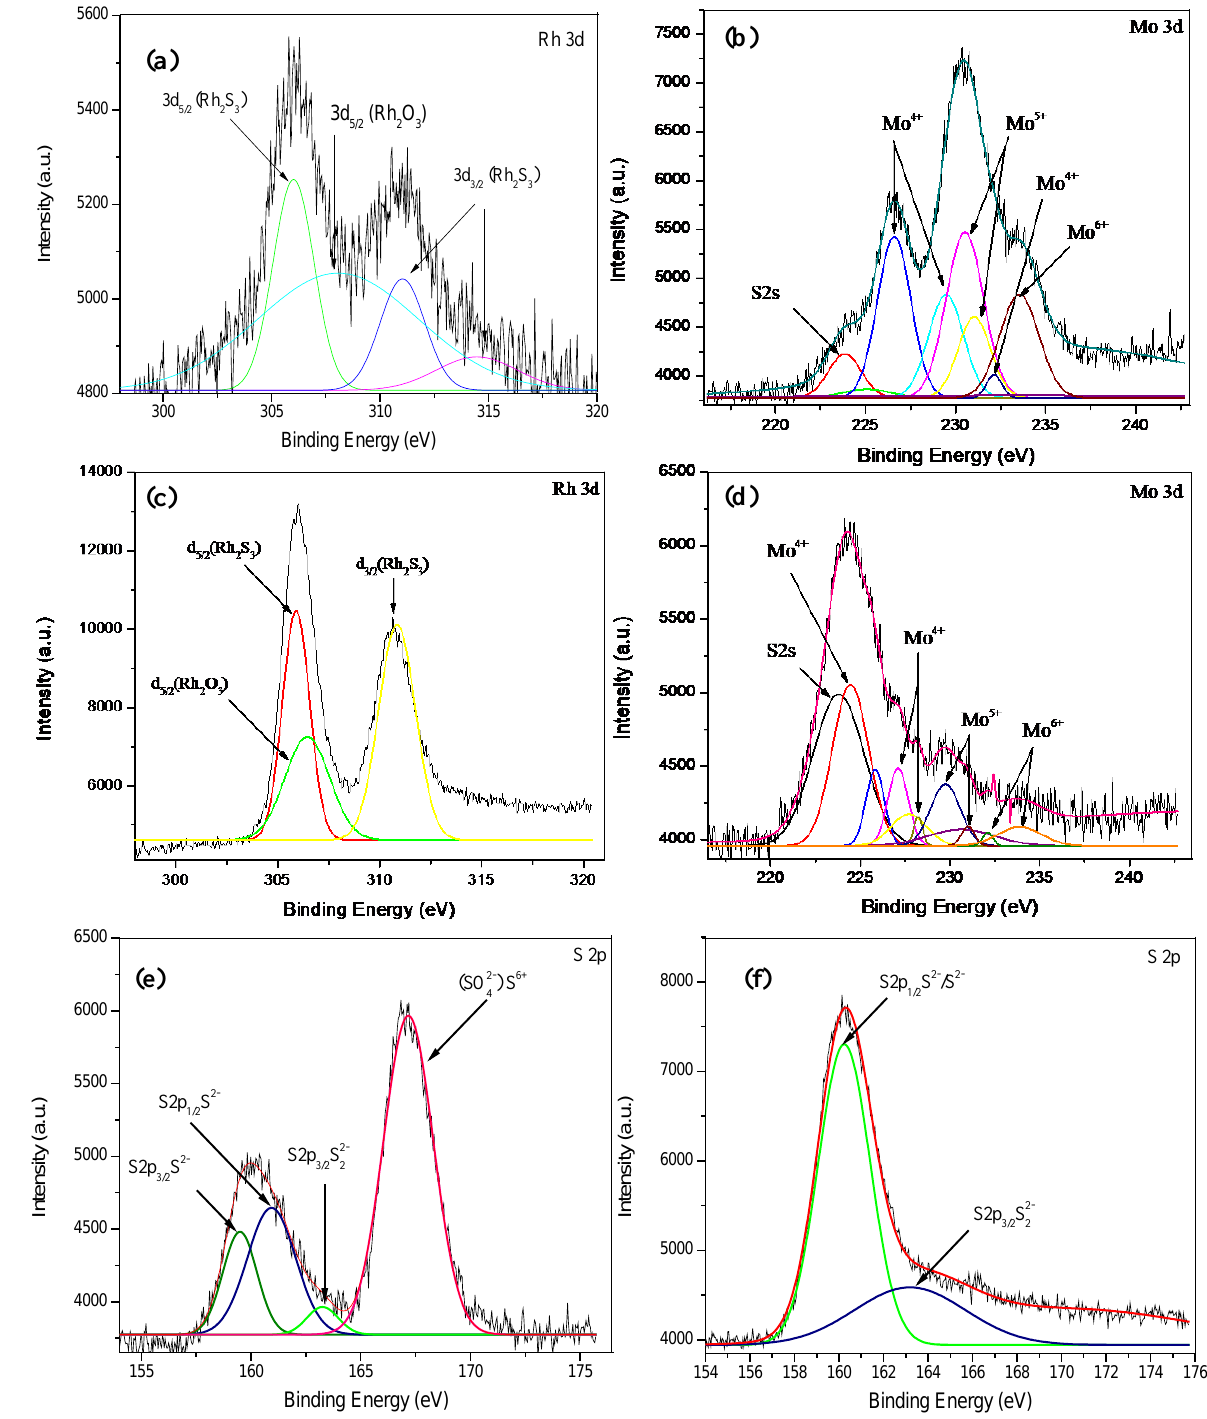
Figure 5. XPS deconvolution of RhMo/ ɣ -Al 2 O 3 and RhMo-EDTA/ ɣ -Al 2 O 3 , where: ( a ) Rh 3d for RhMo/ ɣ -Al 2 O 3 ; ( b ) Mo 3d for RhMo/ ɣ -Al 2 O 3 ; ( c ) Rh 3d for RhMo-EDTA/ ɣ -Al 2 O 3 ; ( d ) Mo 3d for RhMo-EDTA/ ɣ -Al 2 O 3 ; ( e ) S 2p for RhMo/ ɣ -Al 2 O 3 ; ( f ) S 2p RhMo-EDTA/ ɣ -Al 2 O 3 . The doublet at a binding energy (BE) of (±) 229 eV and (±) 232.1 0.1 eV was attributed to Mo 3d 5/2 and Mo 3d 3/2 levels of MoS 2 (Mo 4+ ), and the two contributions observed at (±) 230.0 eV and (±) 235.3 0.1 eV were assigned to Mo 3d 5/2 and Mo 3d 3/2 of Mo oxysulfide (MoO x S y , Mo 5+ ) [59], while the binding energy of the Mo 3d 5/2 component located at (±) 232.2 0.1 eV was assigned to the Mo 6+ (MoO x ) species [60], and for the Mo 3d